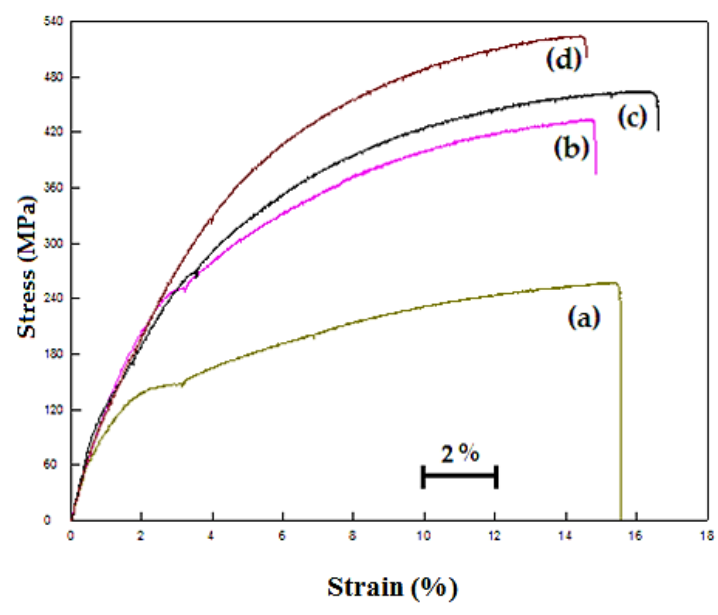
Figure 6. The stress-strain curves for the PM steel and microalloyed PM steels at different percentages ofNb-V content and 1350 °C temperature: ( a ) Alloy 1, ( b ) Alloy 2, ( c ) Alloy 3, and ( d ) Alloy 4.